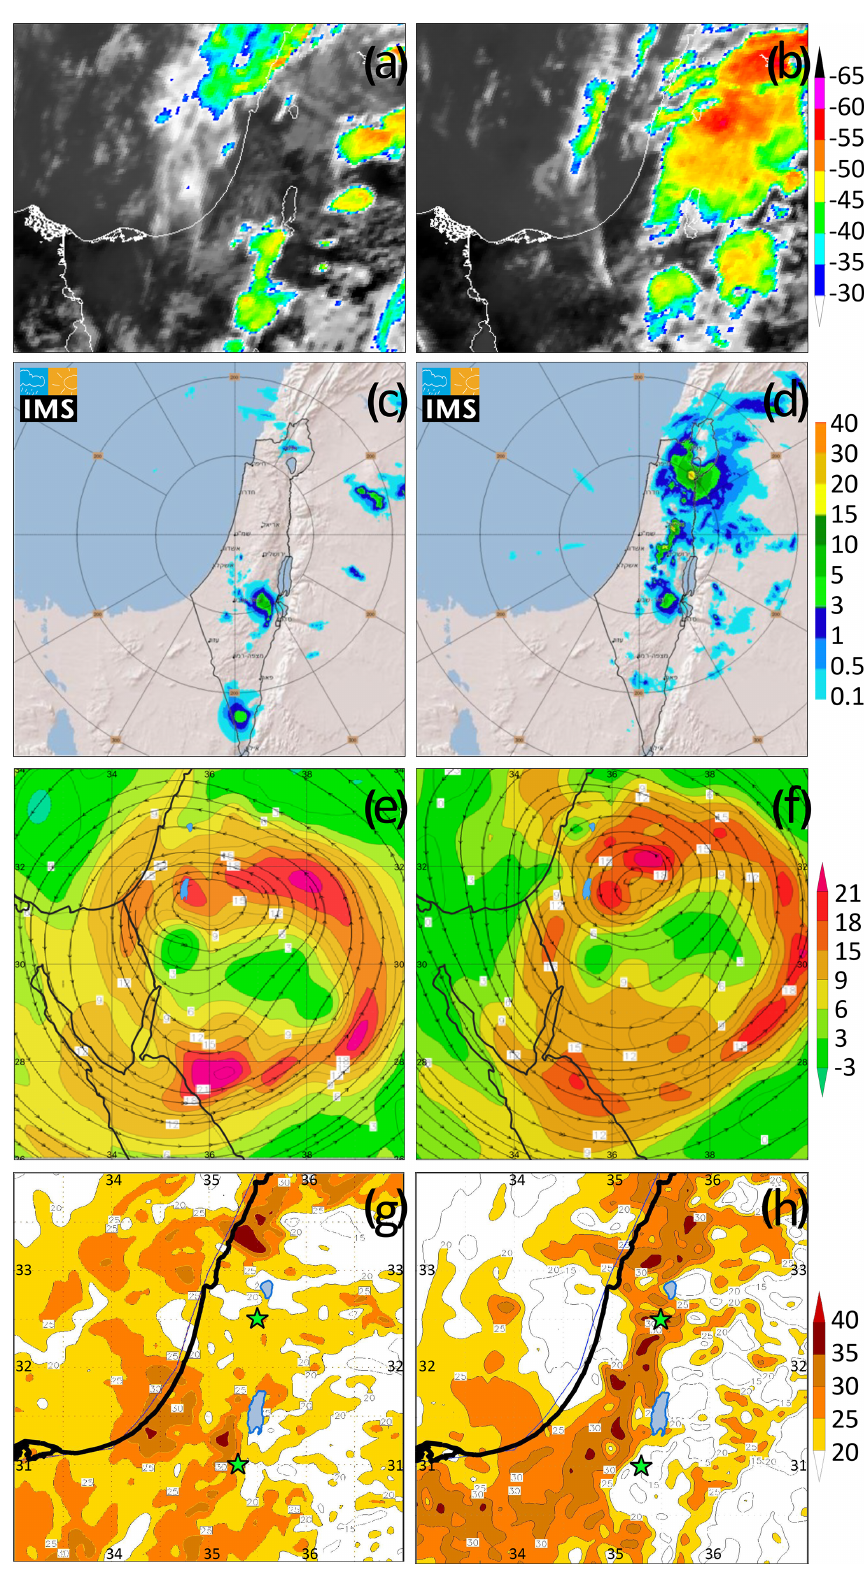
Figure 8. The 26 April imageries for 09:00 (a, c, e, g) and 12:00UTC (b, d, f, h) corresponding to the major rain centres including Meteosat Second Generation (MSG) IR images (a, b) , 1h forward integration radar (mmh − 1 ) images (c, d) , relative vorticity (s − 1 × 10 5 ) and streamlines at 500hPa (e, f) , and MKI ( ◦ C) (g, h) . Panels (e) and (f) are based on ERA5 data at 30km spatial resolution, and (g) and (h) are based on the COSMO model at 2.8km spatial